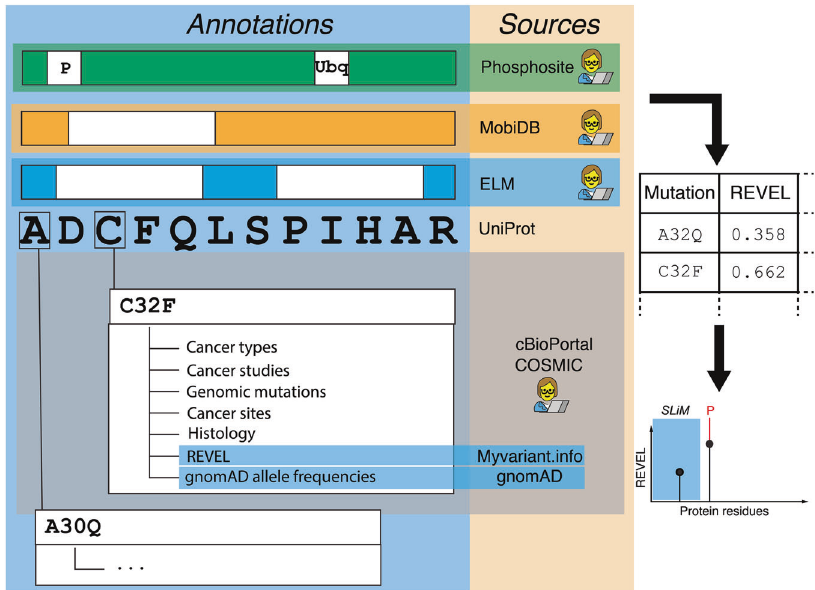
Fig. 1 Schematic representation of the Cancermuts work fl ow. The fi gure shows on the left the different layers of evidence that Cancermuts supports. The Uniprot main isoform sequence is the basis on which either per-position or per-sequence annotations are performed (post- translational modi fi cations, structure de fi nition, linear motifs) that can be provided by one of the sources and by manual user annotation. The sequence can also be annotated by downloading cancer-related mutations and relative metadata, including REVEL scores and gnomAD allele frequencies. Mutations can be supplied by manual annotation as well. Once the information has been collected, it can be summarized as a table (right) and as a plot (bottom